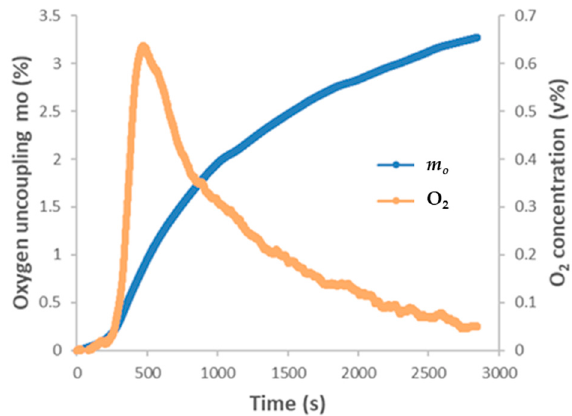
Figure 4. The Cu-OC oxygen uncoupling (TGA) and gaseous O 2 concentrations (QMS) versus time at 900 °C in Ar in a TGA-QMS.